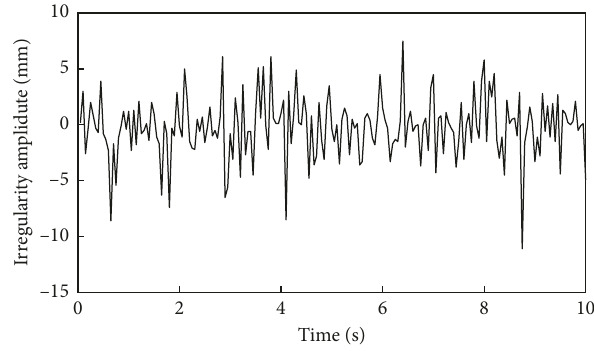
Figure 2: Track random irregularity. Table 1: Vehicle parameters in specific